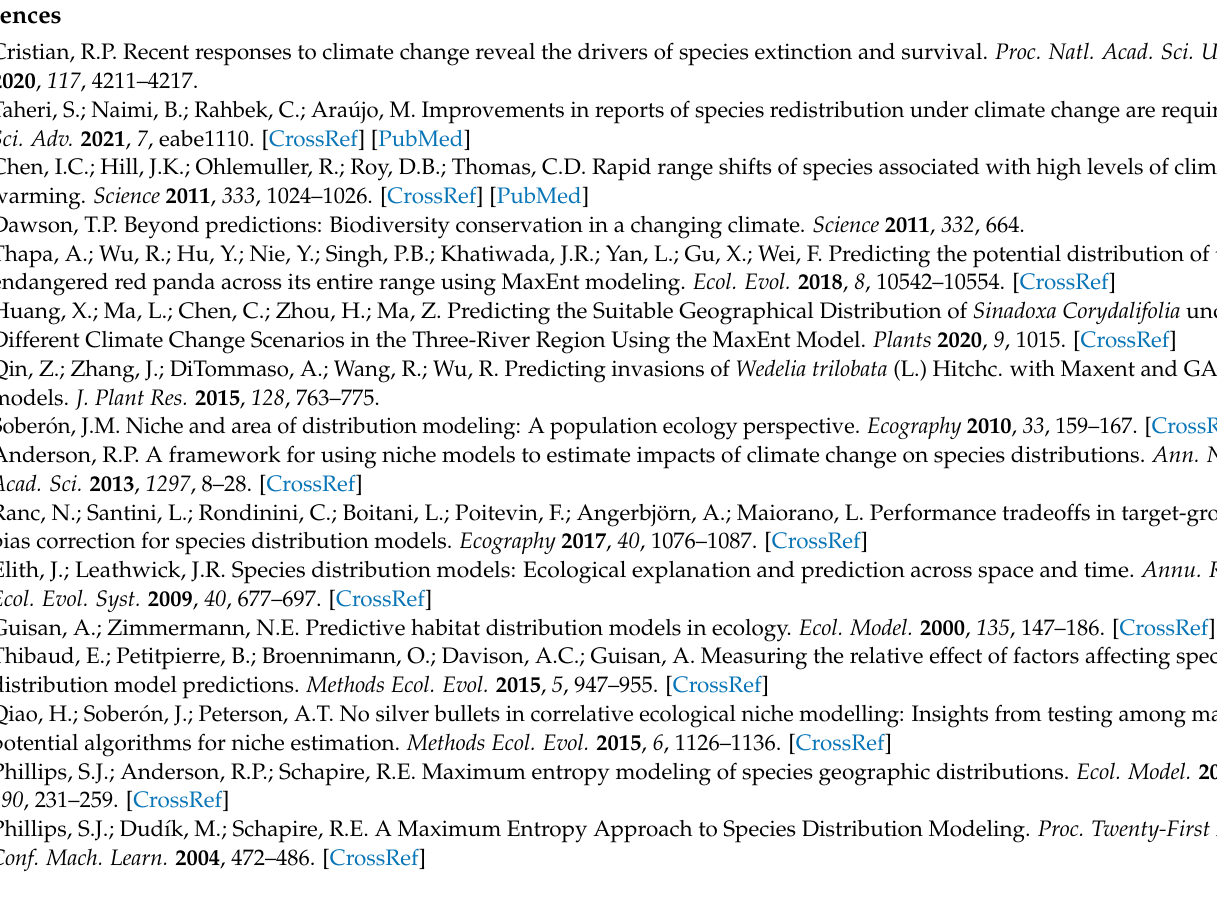
China, Figure S2: The geographical distribution of Morchella in LGM and MH periods, Figure S3: The current geological distribution of Morchella, Figure S4: The change in potential suitable habitat area of Morchella in different climatic scenarios, Table S1: Geographical distributions of Morchella species sampled in this study, Table S2: Types of RCPs and projected temperature